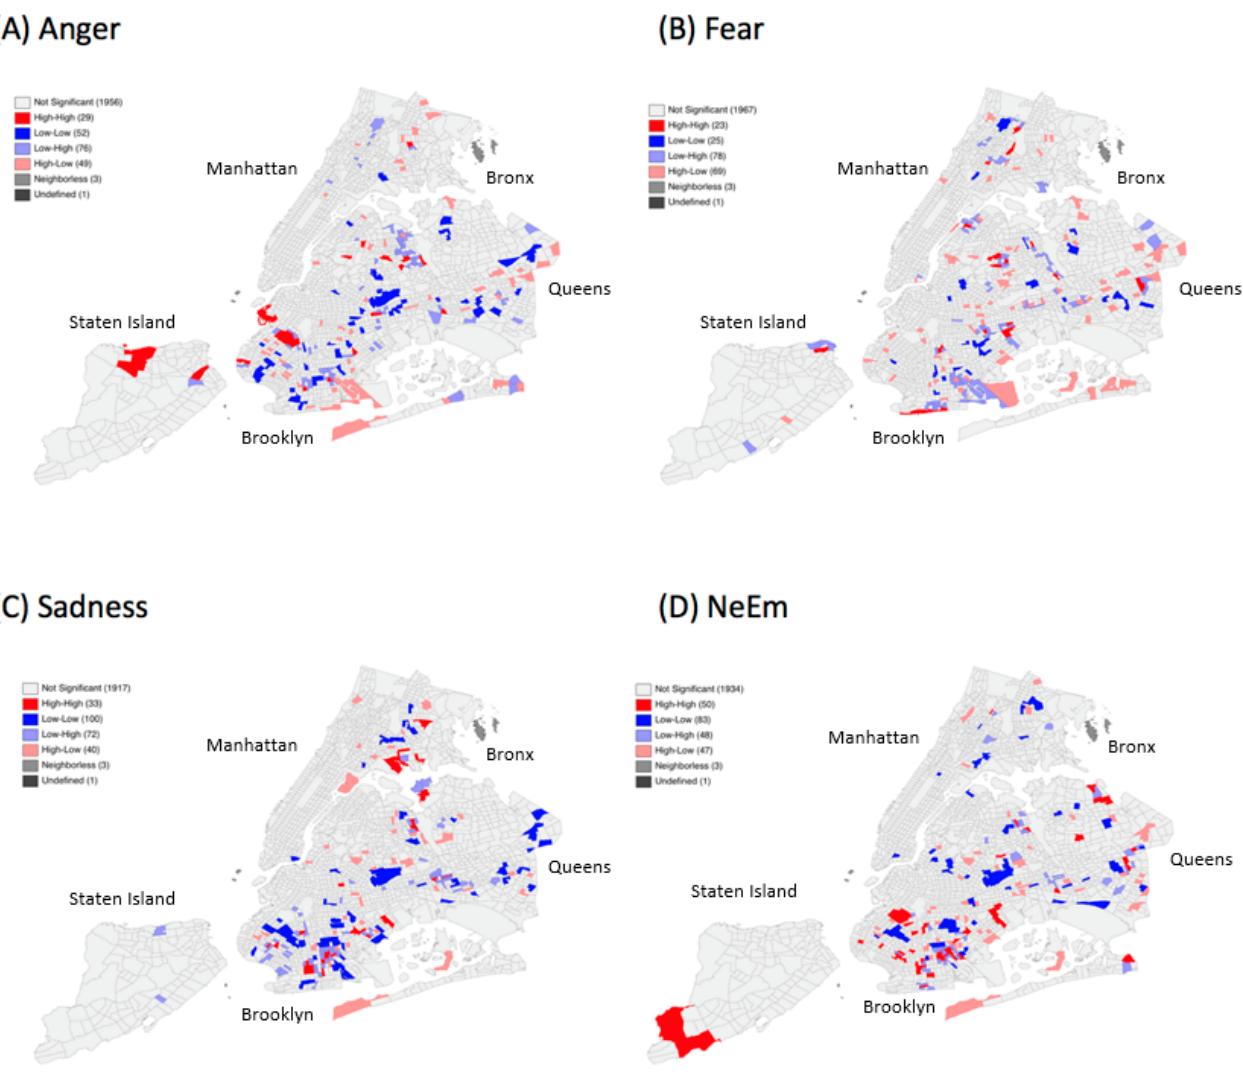
Figure 1. Univariate spatial clusters of ( A ) Anger, ( B ) Fear, ( C ) Sadness, and ( D ) the combined set of negative emotions (NeEm) pre-disaster.